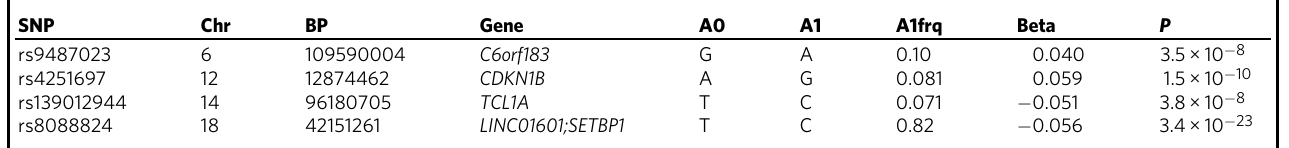
Table 3 Secondary signals in the four known loci